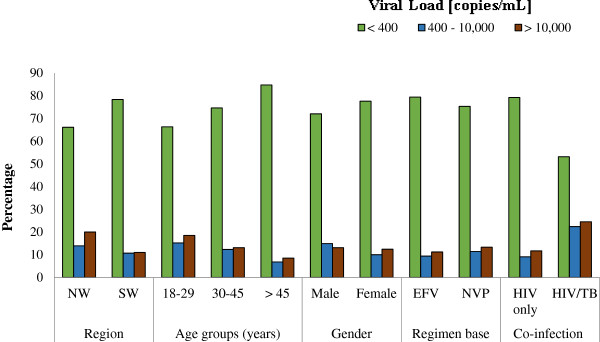
Prevalence of virologic categories among study participants.